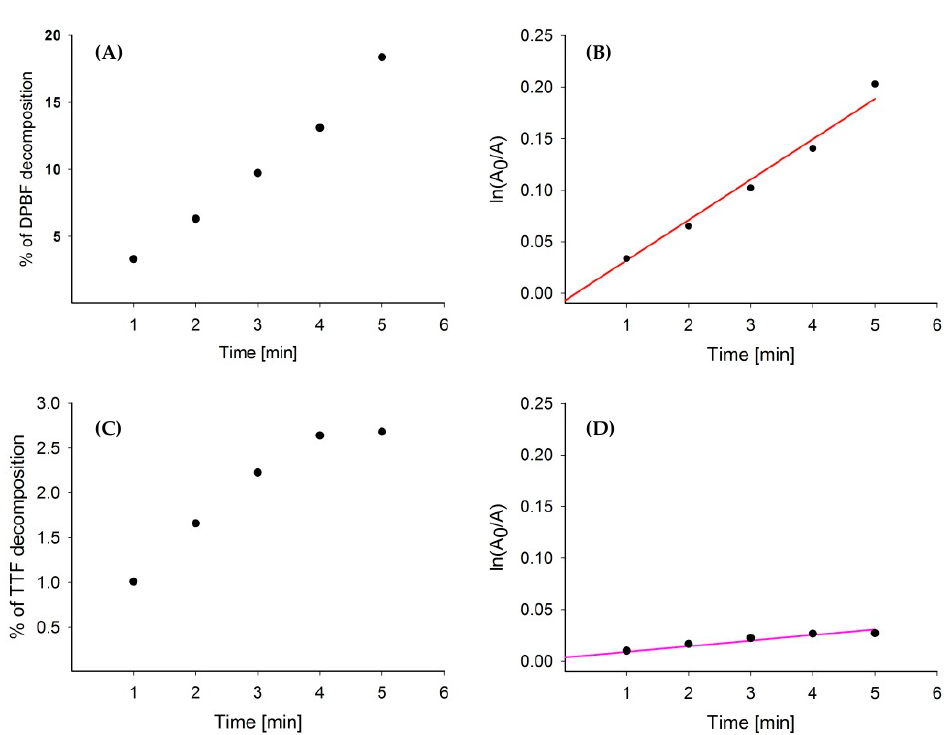
Figure 3. Effect of mixtures RB + DPBF and Ce6 + TTF sonication with 1 MHz, 3 W (40% duty cycle) vs. time: ( A ) % DPBF decomposed in the presence of RB; ( B ) kinetic curve of DPBF decomposition by RB (red); ( C ) % TTF decomposed in the presence of Ce6; ( D ) kinetic curve of TTF decomposition by Ce6 (pink).